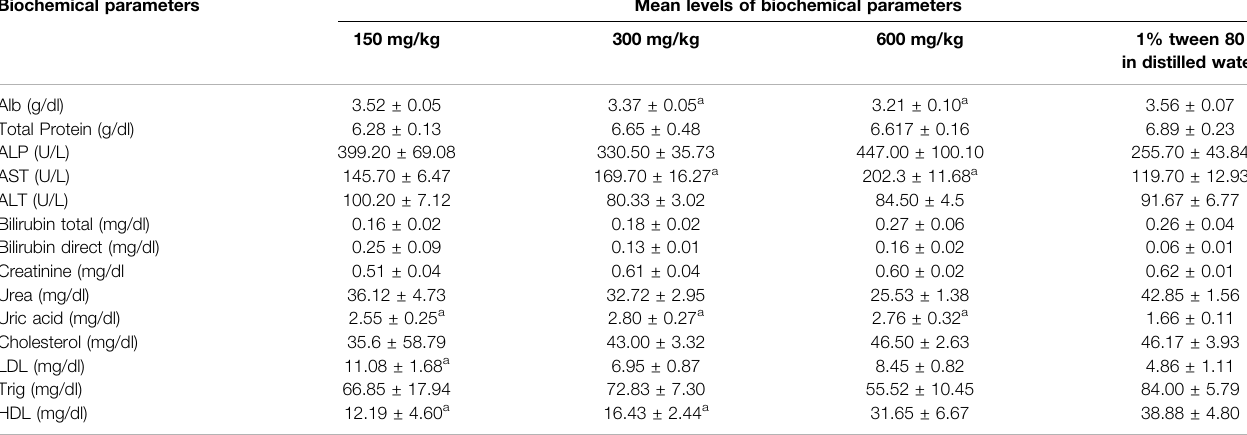
TABLE 2 | Mean levels of biochemical parameters after 28 days at different doses of the extract. Biochemical